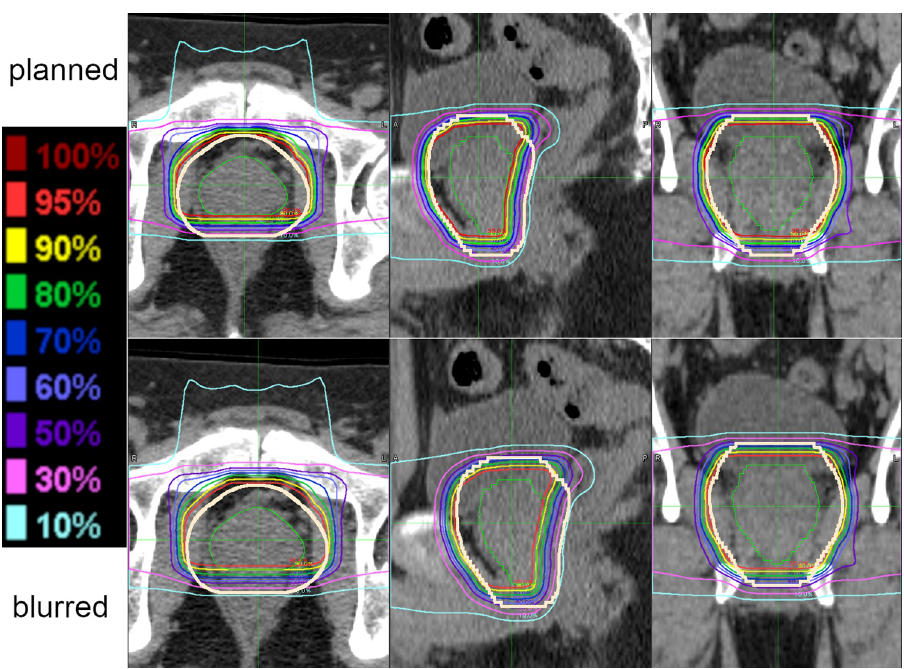
Fig 3. Planned and blurred dose distributions. Planned (upper) and most probable (lower) dose distributions in transverse (left), sagittal (middle), and frontal (right) planes with bold khaki line demarcating a one-centimeter margin around the prostate in which probable dose is reliable.